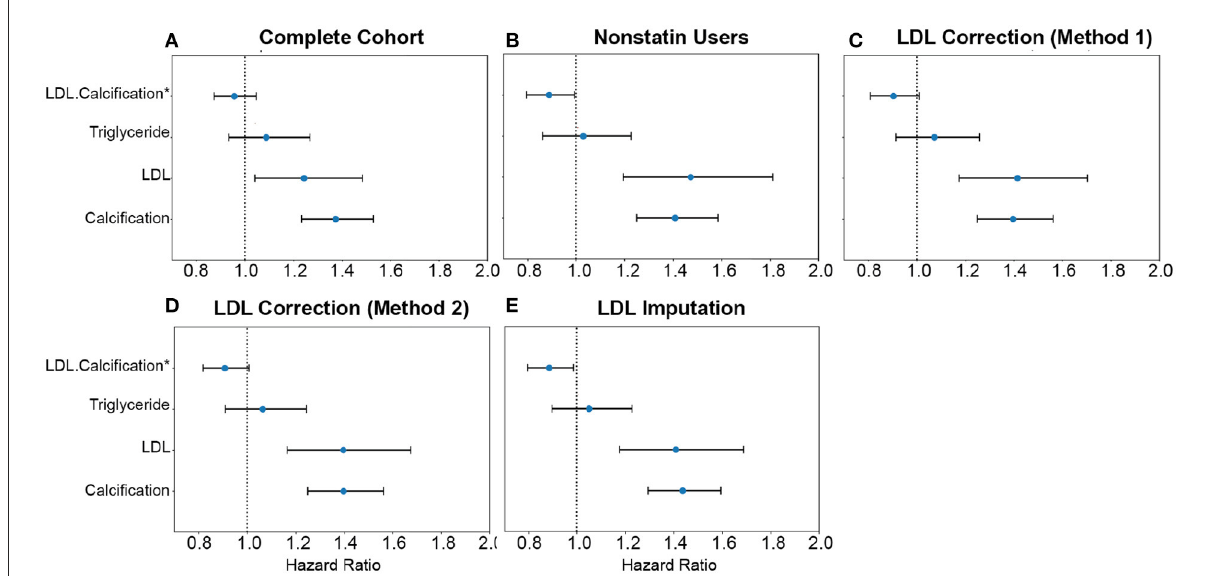
FIGURE9 Comparison of AAC and statin-adjusted LDL hazards on Myocardial Infarction Outcome. We compared the hazard ratios for AAC, LDL, and triglycerides using a multivariate CoxPH model with age and sex covariates. (A) Complete cohort- a whole cohort with no statin adjustment. (B) Non-statin users only. (C) The whole cohort after adjusting for statin using method 1—assumes that LDL levels are reduced by 1.25 mmol/L in statin users. (D) The whole cohort method 2—assumes that LDL levels are reduced by 35% in statin users. (E) The whole cohort imputation of LDL levels is based on remaining biomarkers and physiological measurements. The blue dots represent the mean hazard ratio, while error bars represent 95% confidence intervals. The interaction term between LDL and calcification is starred. This analysis was done with 11.8 years of median follow-up time post-baseline visit during which LDL was